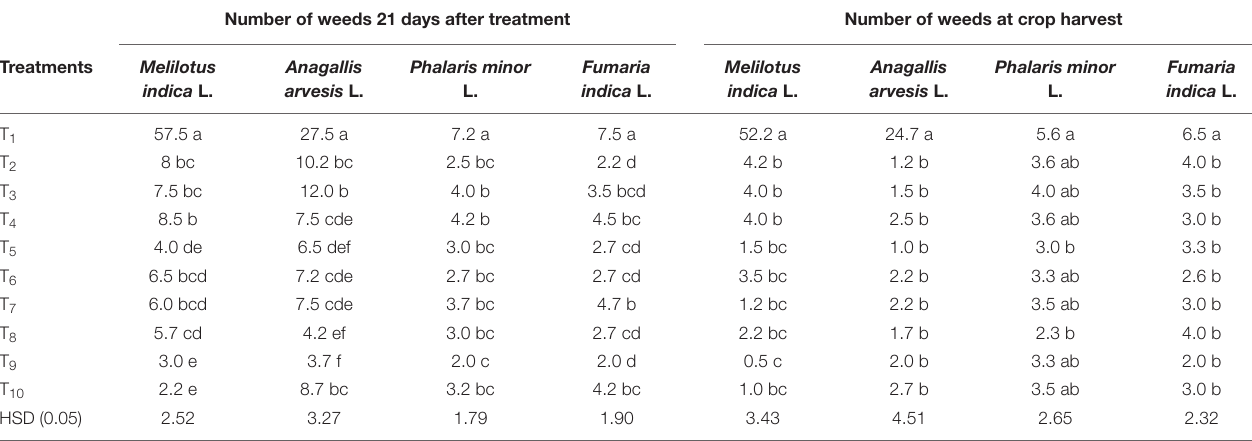
TABLE 3 | Influence of metribuzin alone and with adjuvants on a number of weeds (m − 2 ) 21 days after herbicide application and at the harvest of wheat (average of 2 years’ data). Number of weeds 21 days after treatment Number of weeds at crop harvest Treatments